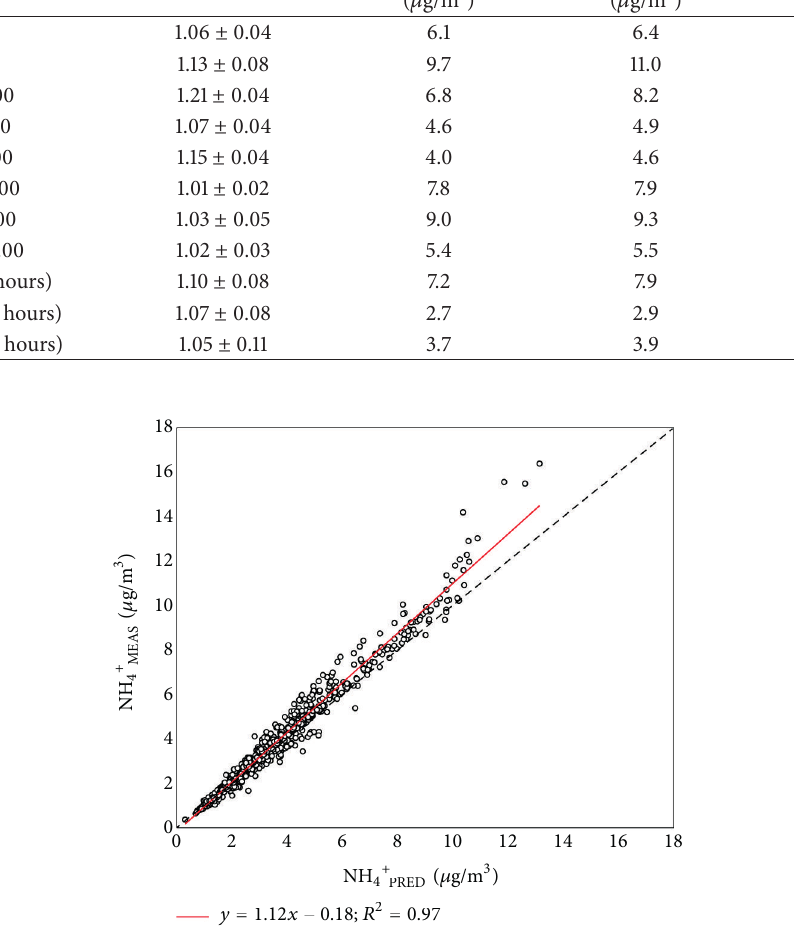
Figure 5: Linear correlation between the predicted amount of ammonium (= [ NH 4+ ] ) for the entire study period ( 𝑛 = 660 [ NH 4+ ] MEAS